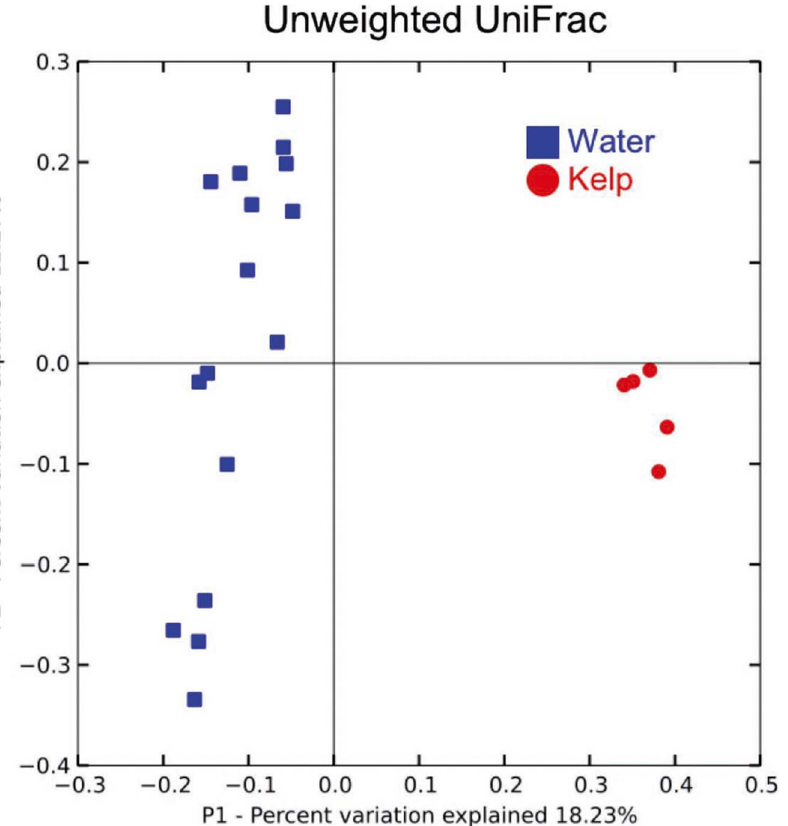
Figure 3. Unweighted UniFrac principal coordinates analysis (PCoA) plots computed at exactly 510 sequences/sample illustrate the relationship between sample type (blue = water, red = kelp) community similarities. Percentages of variance explained by each principal coordinate (P1 and P2) are shown on the x- and y-axes.